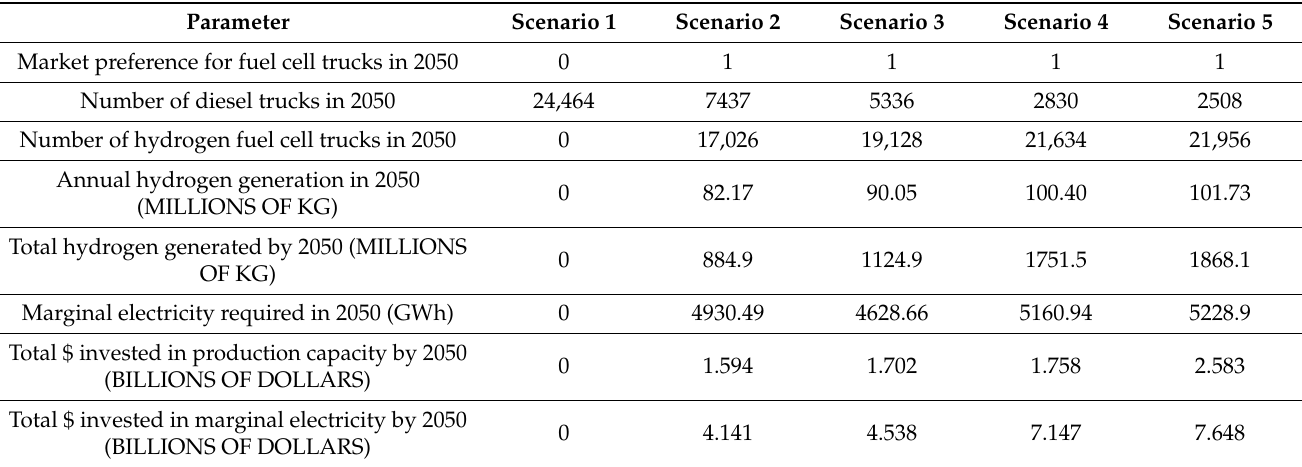
Table 2. Key results from modelled